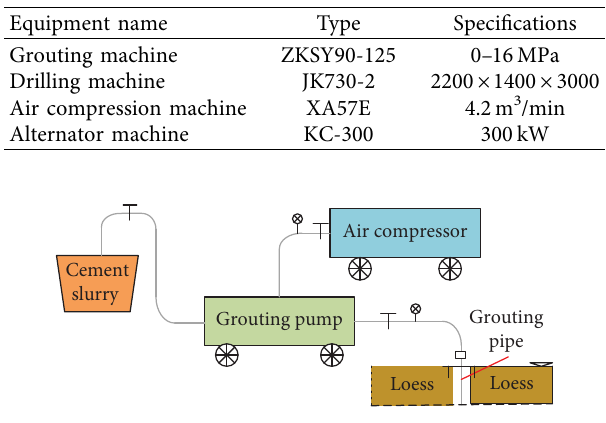
Figure 4: Grouting system.